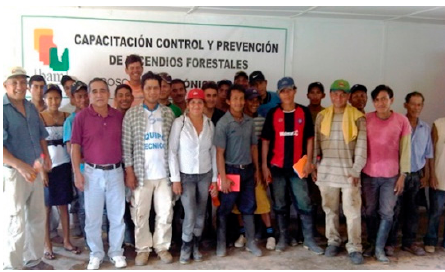
Figure 16. Participants in a training on control and prevention of forest fires